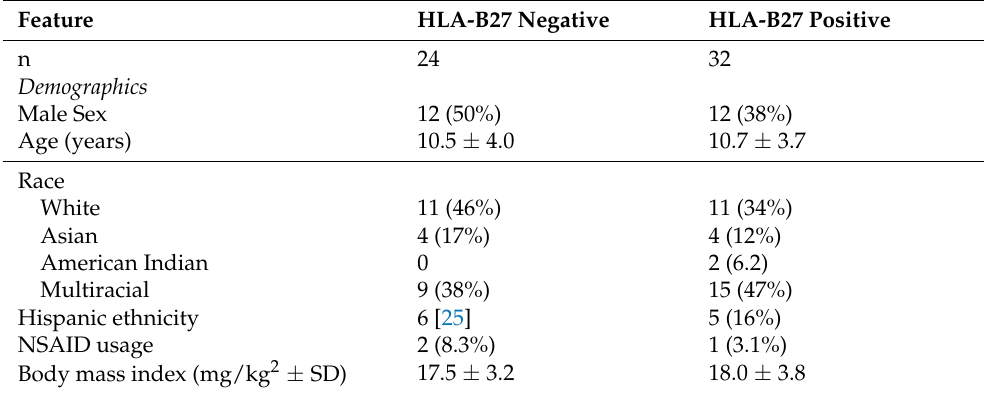
Table 2. Demographic and clinical variables of the study population. Abbreviations: NSAIDs, nonsteroidal anti-inflammatory